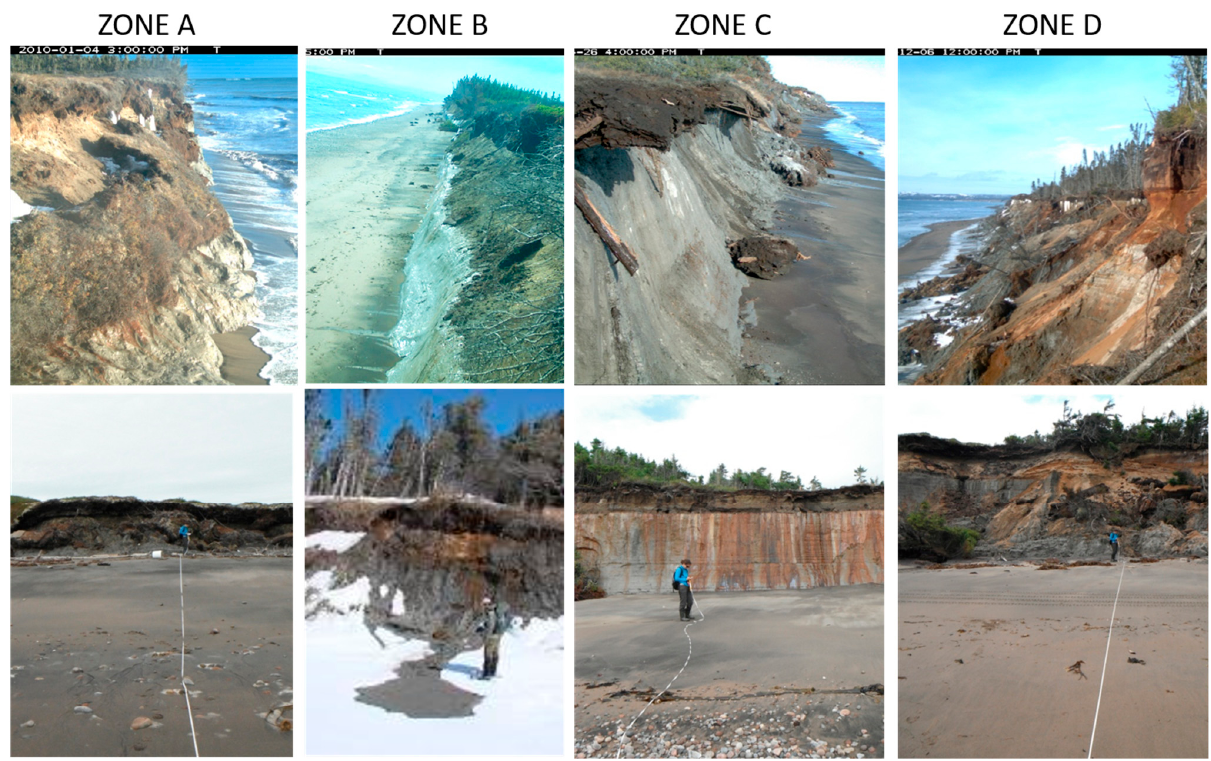
Figure 3. Monitoring zones at Rivière Saint-Jean, Québec. The upper images are from fixed cameras and lower images are the corresponding pictures taken in the field.